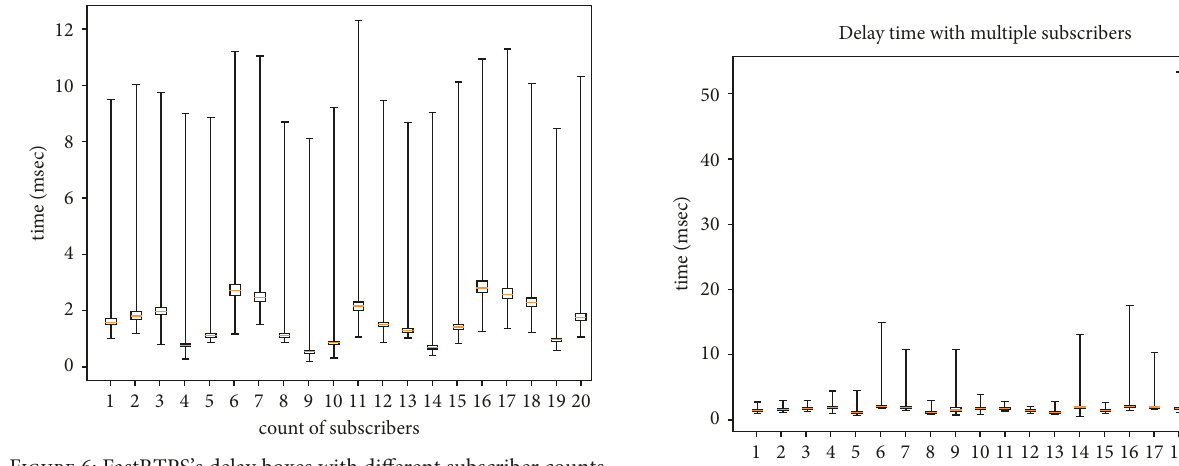
Figure 6: FastRTPS’s delay boxes with different subscriber counts.